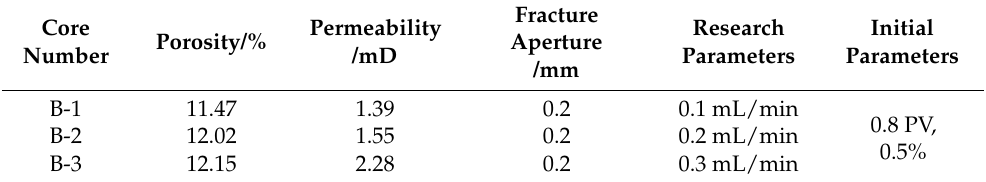
Table 9. Experimental schemes of PEG in low-permeability fractured reservoirs.